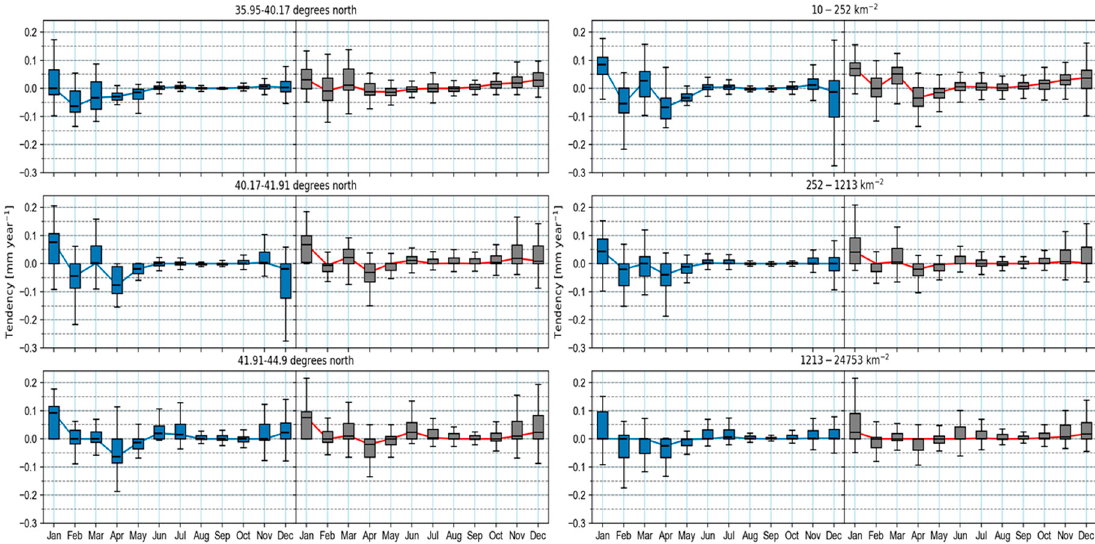
Figure 8. Seven-day low flow tendency by latitude ( left ) and area ( right ) for the model results (blue line) and USGS streamflow Gages II